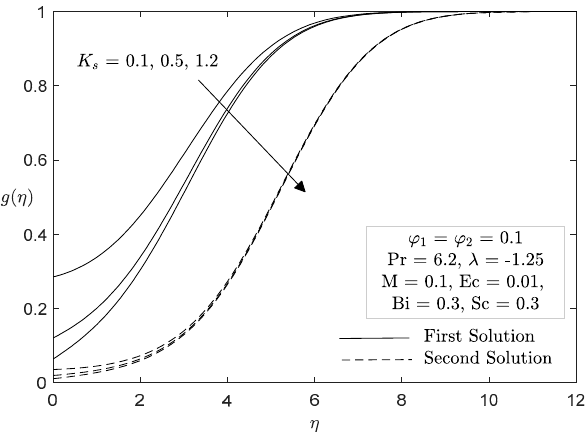
Mathematics 2020 , 8 , x FOR PEER REVIEW 13 of 16 Figure 11. Concentration profile for various values of Figure 11. Concentration profile for various values of K s .